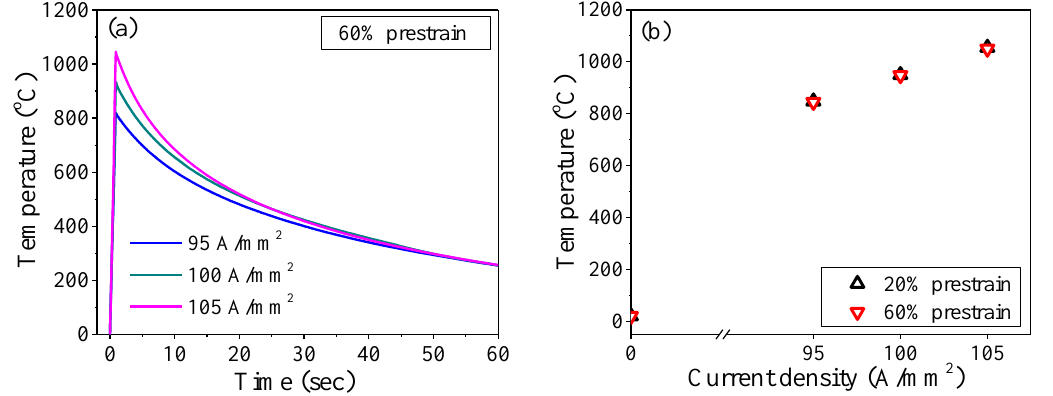
Figure 3. ( a ) Temperature histories of 60% prestrained specimens and ( b ) the peak temperatures as functions of current density during EA annealing for different prestrains.